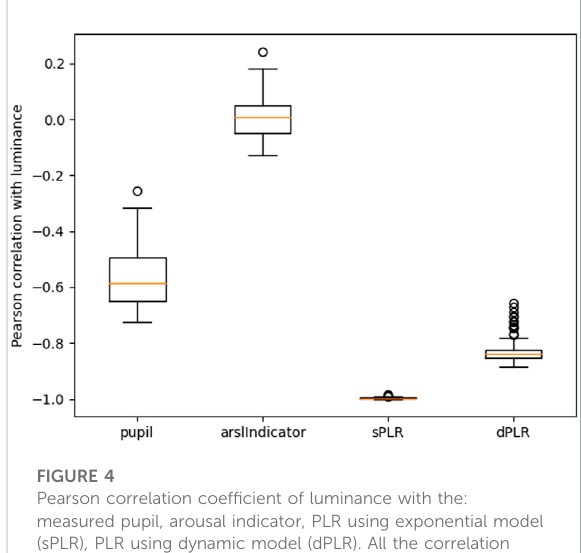
FIGURE 6 Example of pupil measurements (black), steady state model estimate (blue), dynamic model estimate